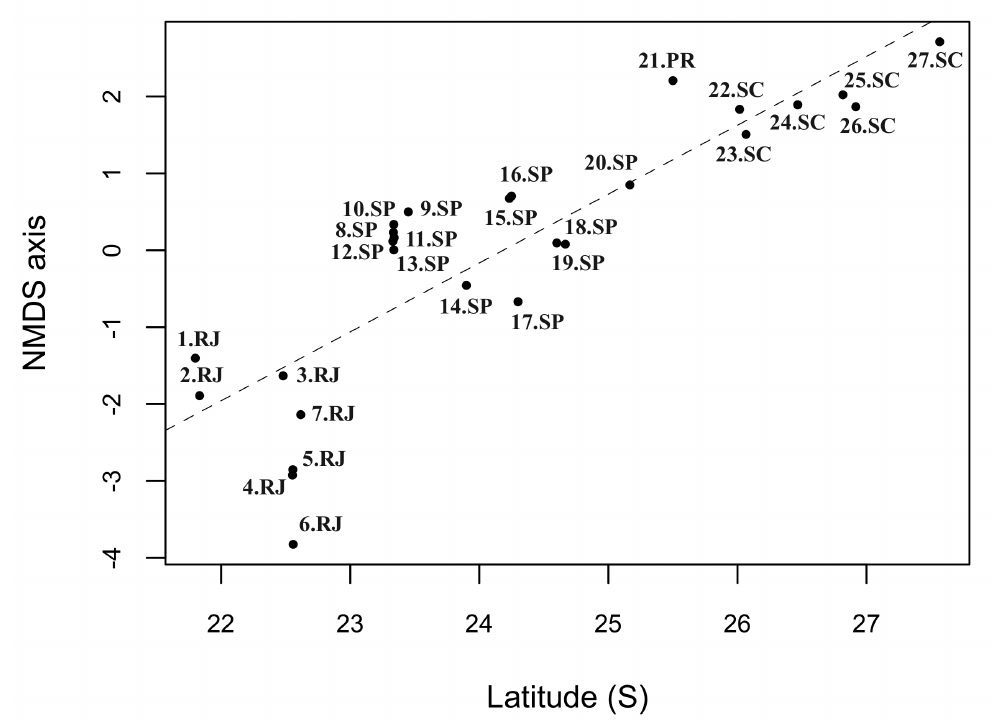
Figure 3 – Linear regression analysis between the NMDS axis (representing the variation in floristic composition) and the latitudinal position of the 27 sample areas distributed along the coastal region of the southeastern Atlantic Forest ( r 2 = 0.74, P < 0.001). RJ = Rio de Janeiro State, SP = São Paulo, PR = Paraná and SC = Santa